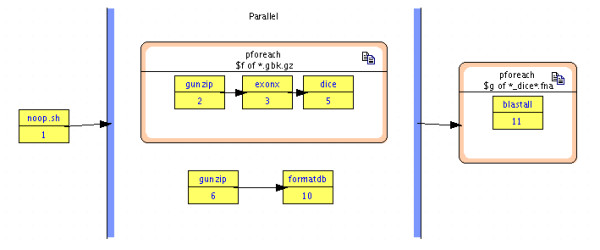
Tissue-specific gene expression analysis. We initially start with 24 compressed genbank files, one for each human chromosome. We decompress (gunzip) the genbank file, extract (exonx) from it all the exons into one fasta file and then break up (dice) this fasta file into 5 smaller fasta files; we do this for each chromosome in parallel. At the same time, we decompress the file of transcripts and use formatdb to format it for use as a BLAST database. Finally, we blast the exons against the transcript database in parallel. Note that components are rendered as rectangles and the bottom half shows a unique numerical identifier; this can be used to distinguish components derived from the same template, e.g. gunzip:2 and gunzip:6.